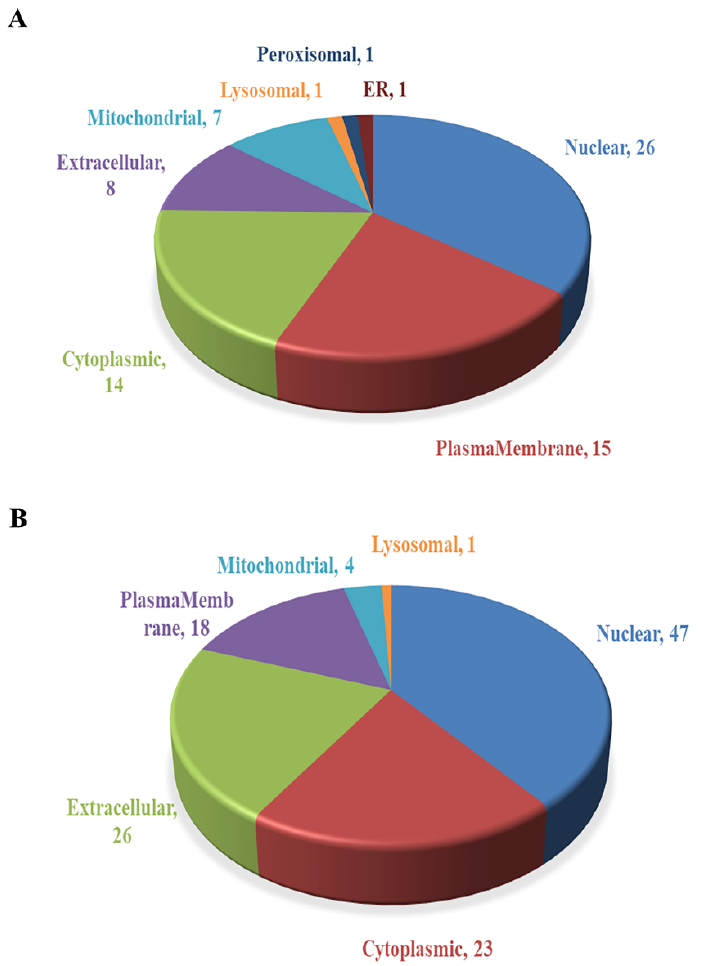
Figure 6. Subcellular localization of DEPs. ( A ) Subcellular localization of up-regulated DEPs. ( B ) Subcellular localization of down-regulated